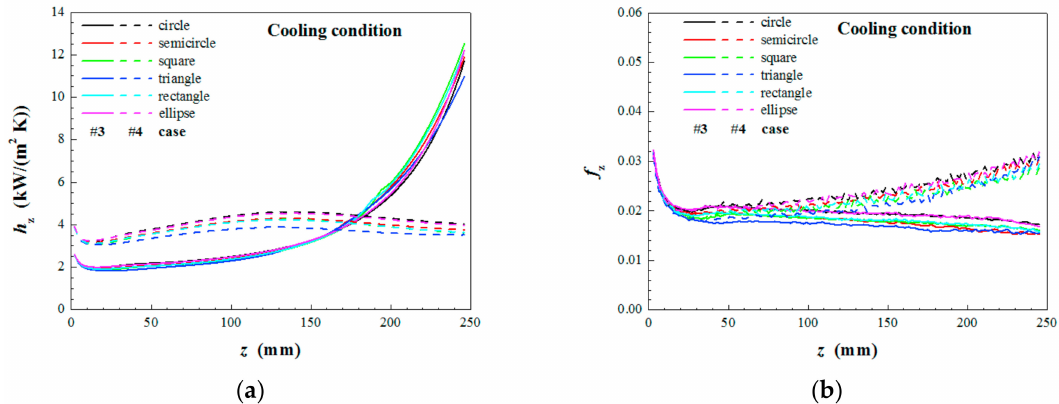
Figure 15. Heat transfer ( a ) and friction factor ( b ) variations for different cross–sections